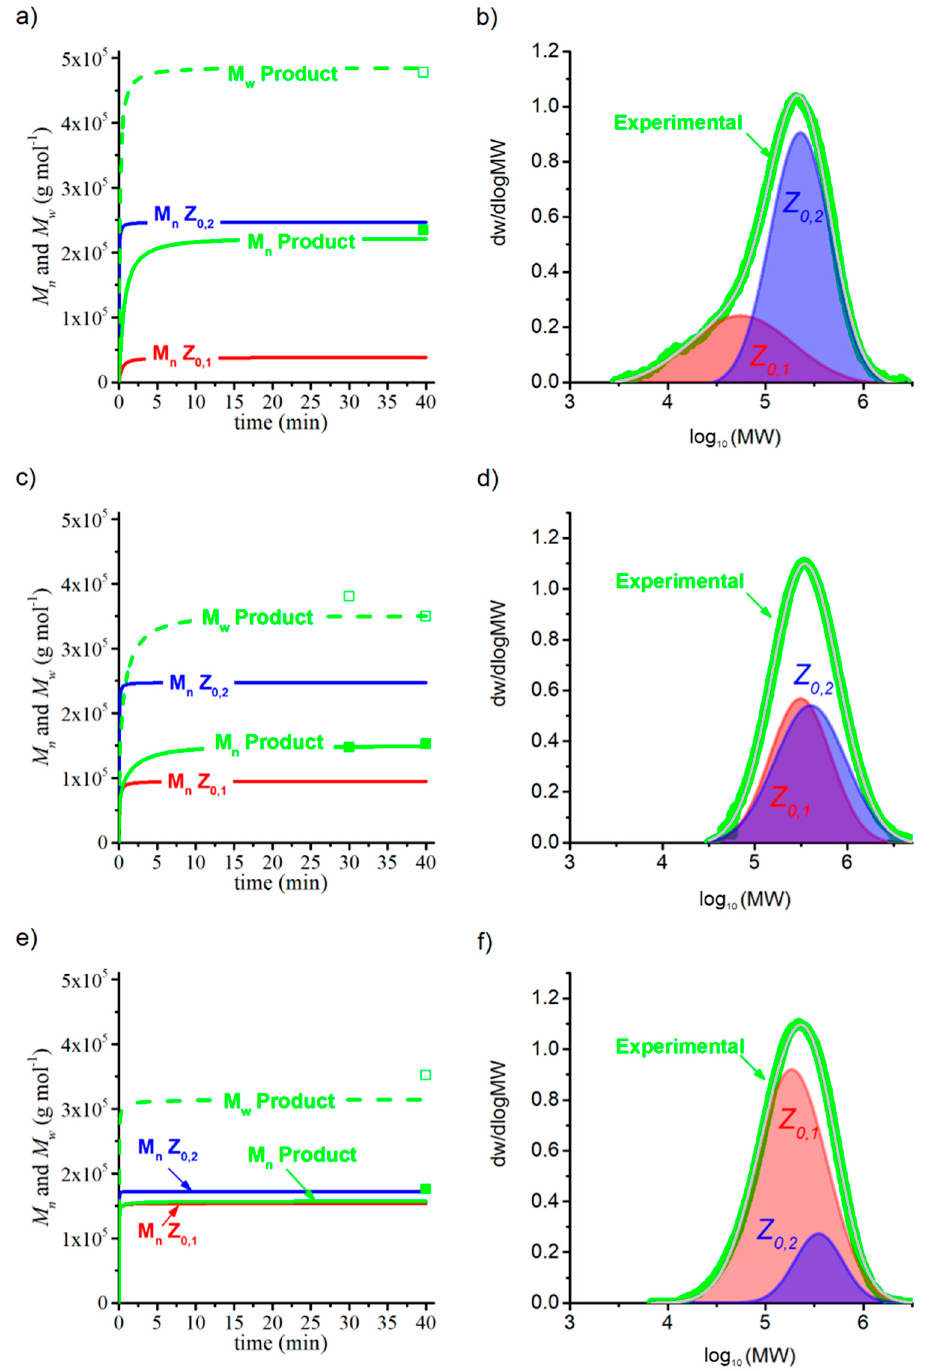
Figure 8. Effect of the temperature variation at 40 ◦ C ( a , b ), 50 ◦ C ( c , d ), and 60 ◦ C ( e , f ) on M n and M w for the final product and both types of polymer species ( a , c , e ) with the experimental data (green symbols) and the simulations (lines), and molecular weight distributions ( b , d , f ) for SEC data (green line) and partial populations (blue and red lines). The ratio of [B] 0 /[Zr] 0 = 2.5 and P = 150 bar. Other operating conditions are shown in Table 6.